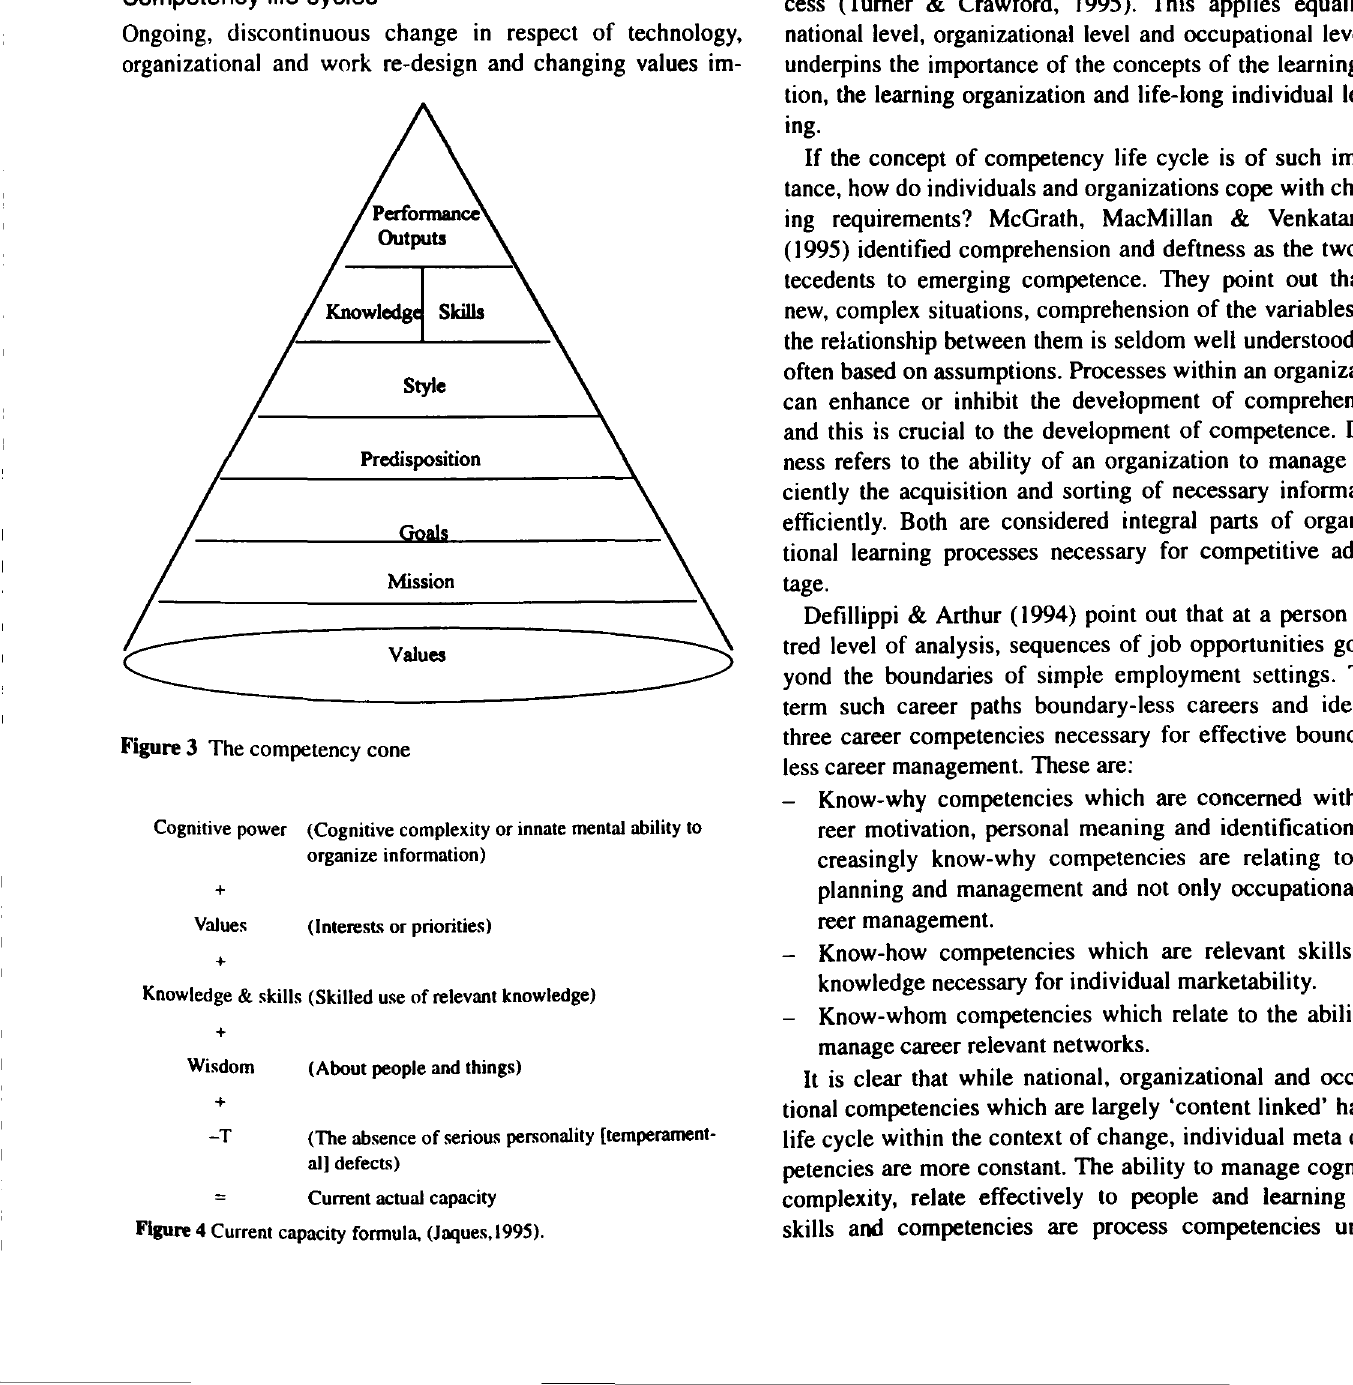
Figure 4 Current capacity formula.